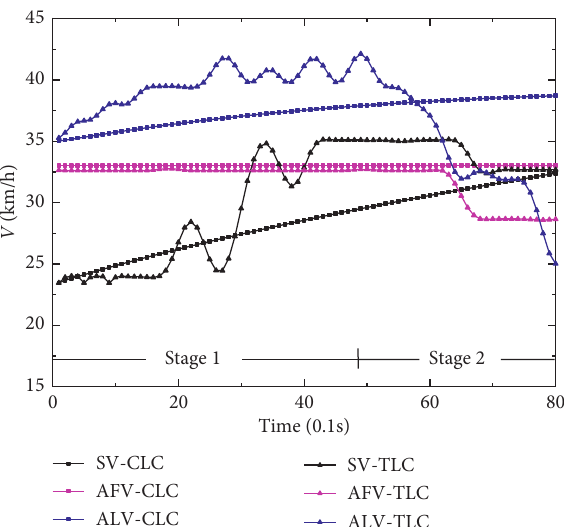
Figure 9: Vehicle speeds during lane changing.